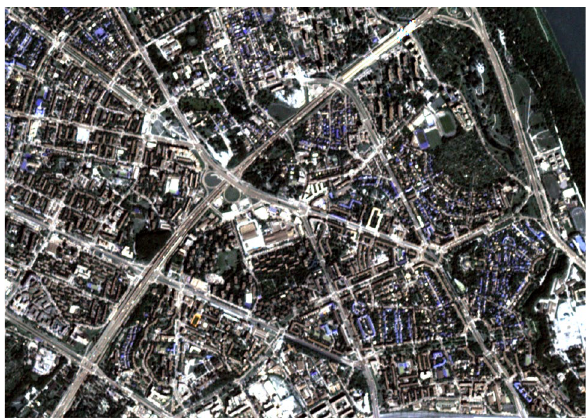
Fig. 3. Example of high - resolution Planet Scope image – the part of Warsaw city (Pl a net, 2018)